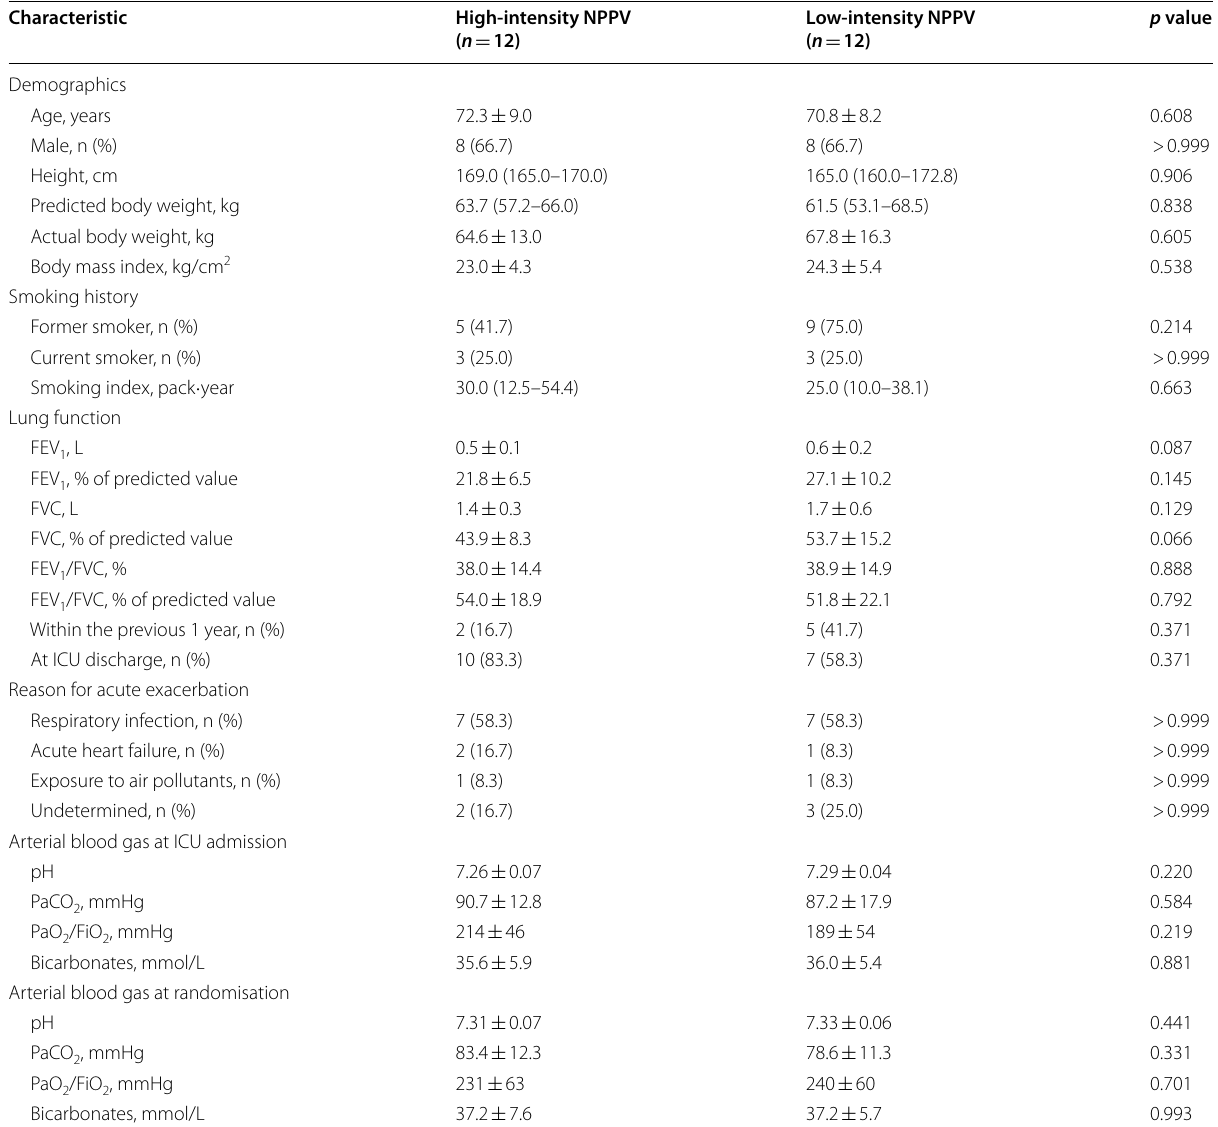
Table 1 Baseline characteristics of the